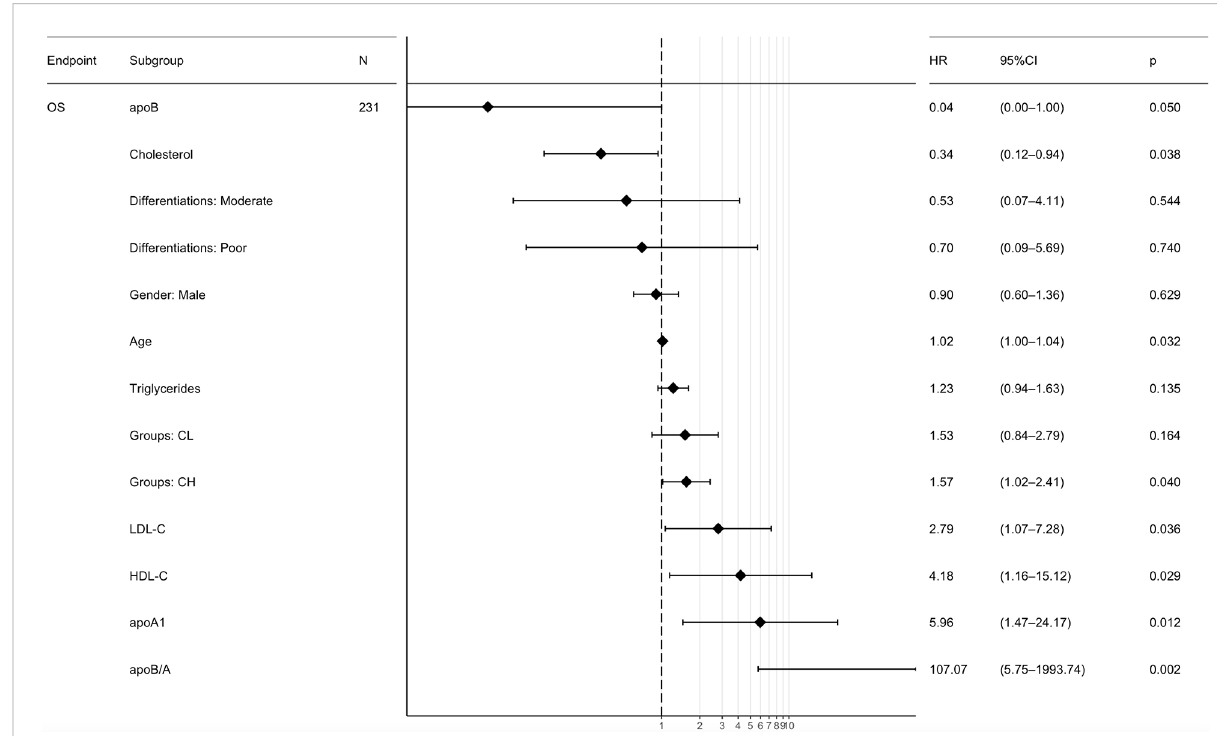
FIGURE 3 Multivariate Cox regression analyses of the prognostic factors for overall survival. ApoB/A, apolipoprotein B/apolipoprotein A-I; OS, overall survival; CL, colorectal cancer lung metastasis; CH, colorectal cancer hepatic metastasis; apoB, apolipoprotein B; apoA1, apolipoprotein A-I; HDL-C, high-density lipoprotein-cholesterol; LDL-C, low-density